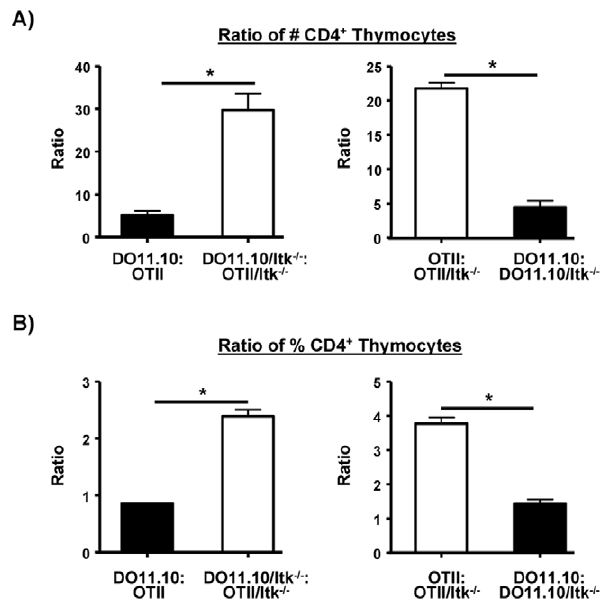
Figure 5. TCR affinity and Itk signals regulate the number of CD4SP cells that develop. ( A ) The ratio of the number of CD4SP thymocytes between the indicated mouse strains were plotted. (B) The ratio of the percentages of CD4SP thymocytes between the indicated mouse strains were plotted.*p , 0.05, n=3–5 mice.